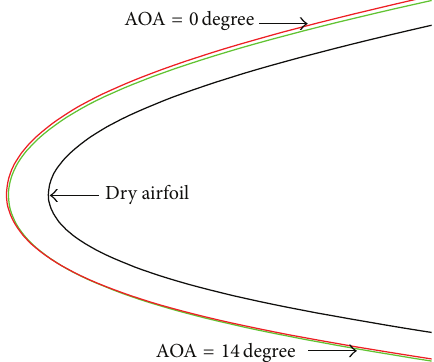
Figure 21: Water film thickness comparison at different angles of attack and LWC = 25 g/m 3